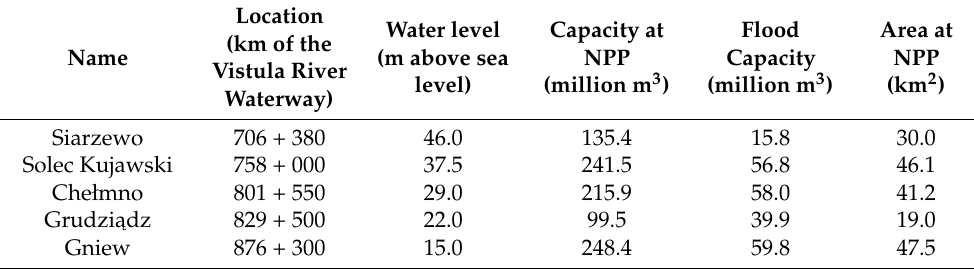
Table 4. Parameters of the planned reservoirs in the Lower Vistula section from Włocławek to the estuary. Location Flood Capacity at Water level (km of the NPP (m above sea Name Vistula River level) Waterway)